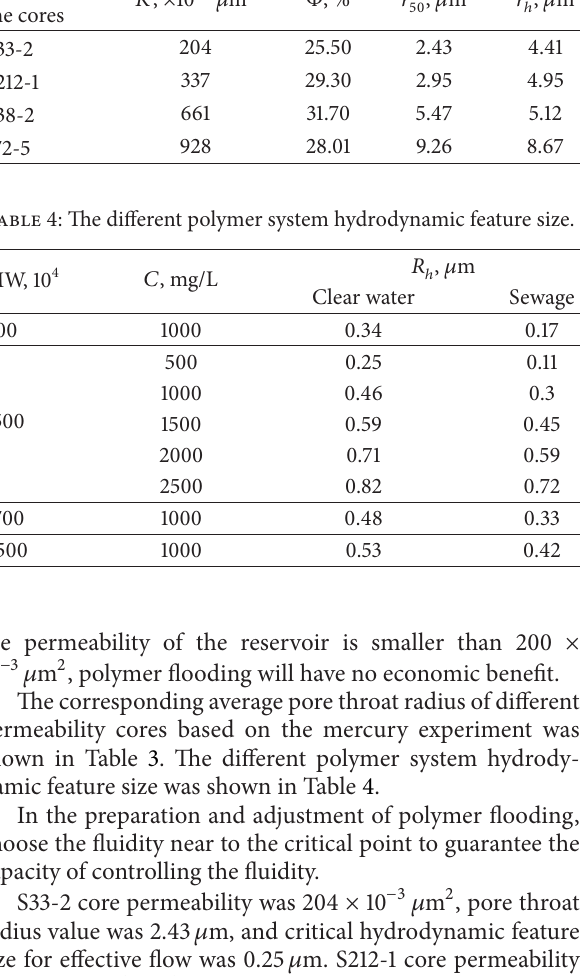
Number of the cores